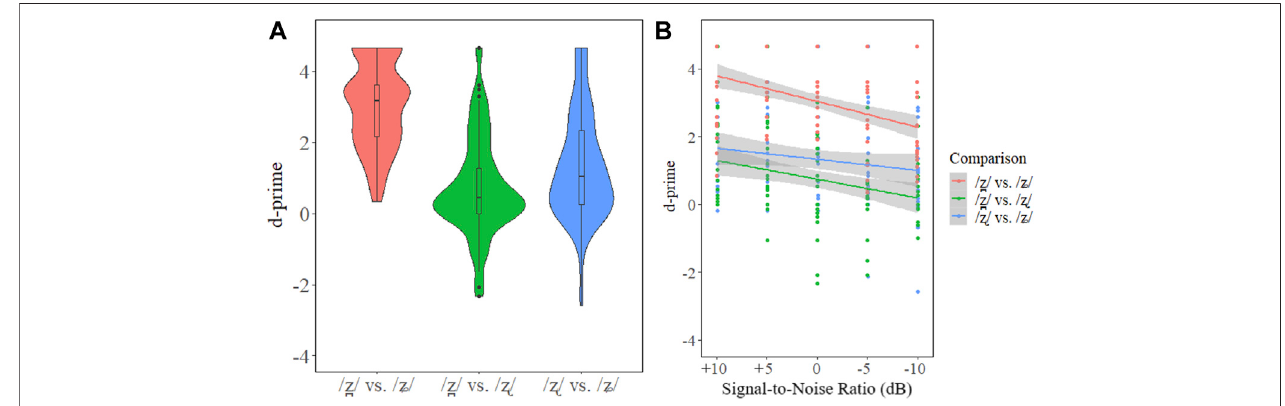
FIGURE 3 | Violin plots for the Polish d-prime results (A) . Scatterplot of the d-prime results with regression lines for the factor Signal-to-Noise (B) .